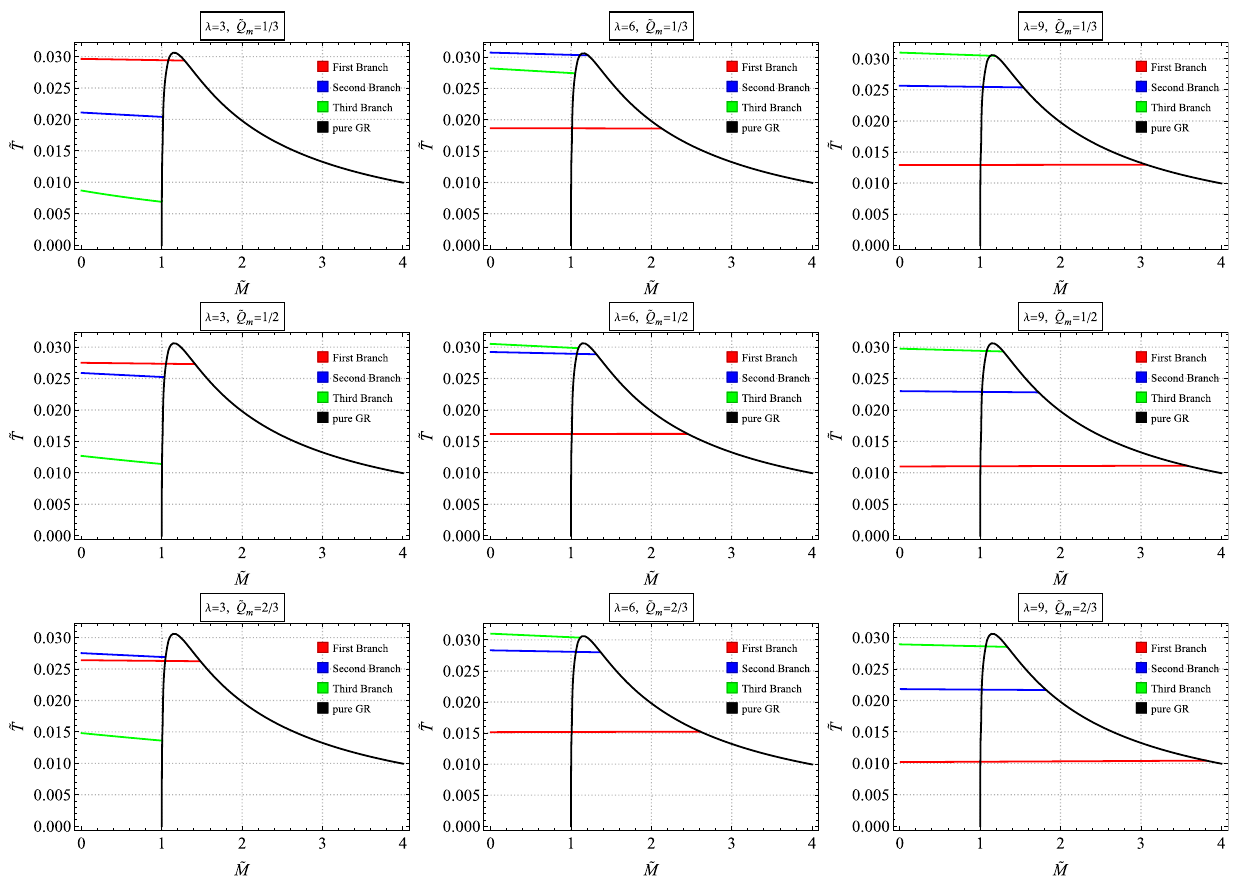
Fig. 8 Plots show the reduced temperature ˜ T of black holes as a function of its reduced mass ˜ M with different values of the coupling constant λ and reduced magnetic charge ˜ Q m for the first three branches of scalarized dyonic RN black